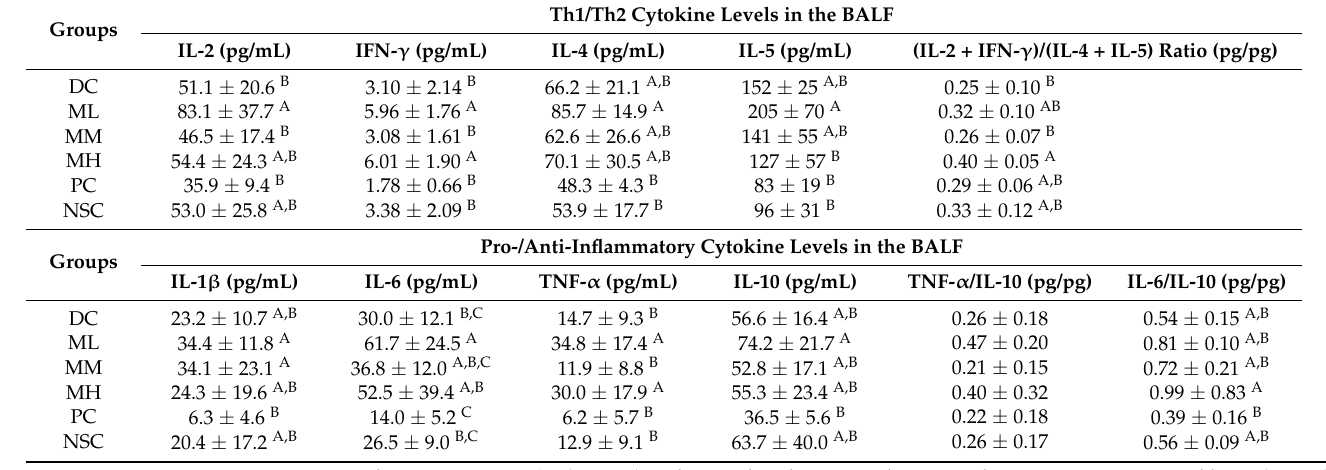
Table 3. Effects of menthone inhalation with different doses on cytokine levels in the BALF of OVA/Al-sensitized and challenged BALB/c asthmatic